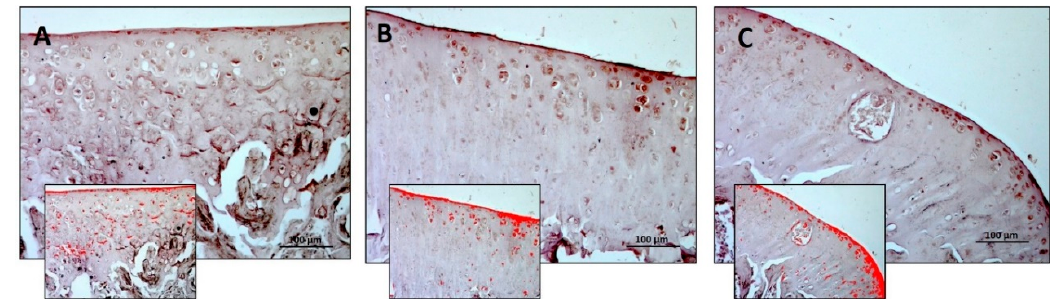
Figure 5. Collagen X (Col X) immunohistochemical evaluation in the articular cartilage through computerised densitometric measurements and image analysis. ( A ) R group; ( B ) R-DS group; ( C ) R-DR group. In inserts are the image analyses by the software in which the red colour represents brown staining (immune complexes labelled with chromogen). For details, see the text. ( A – C ) Objective lens, 10; scale bars: 100 μ m. These are the most representative images of articular cartilage from rats of each group (R, R-DS and R-DR). Table 6. COL X Immunostaining—Articular cartilage.